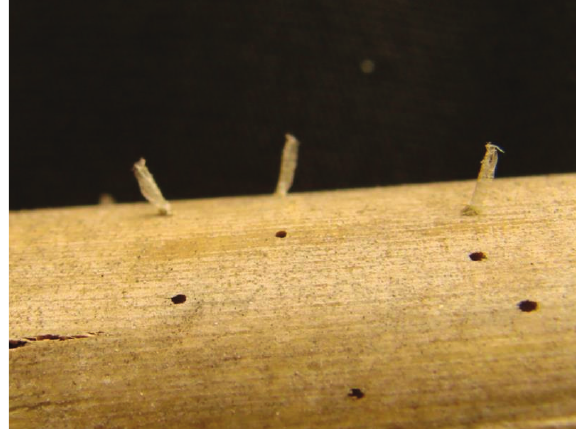
Figure3:Pupalexuviaeprotrudingfromexitholesintheleafsheath following emergence of the adults.